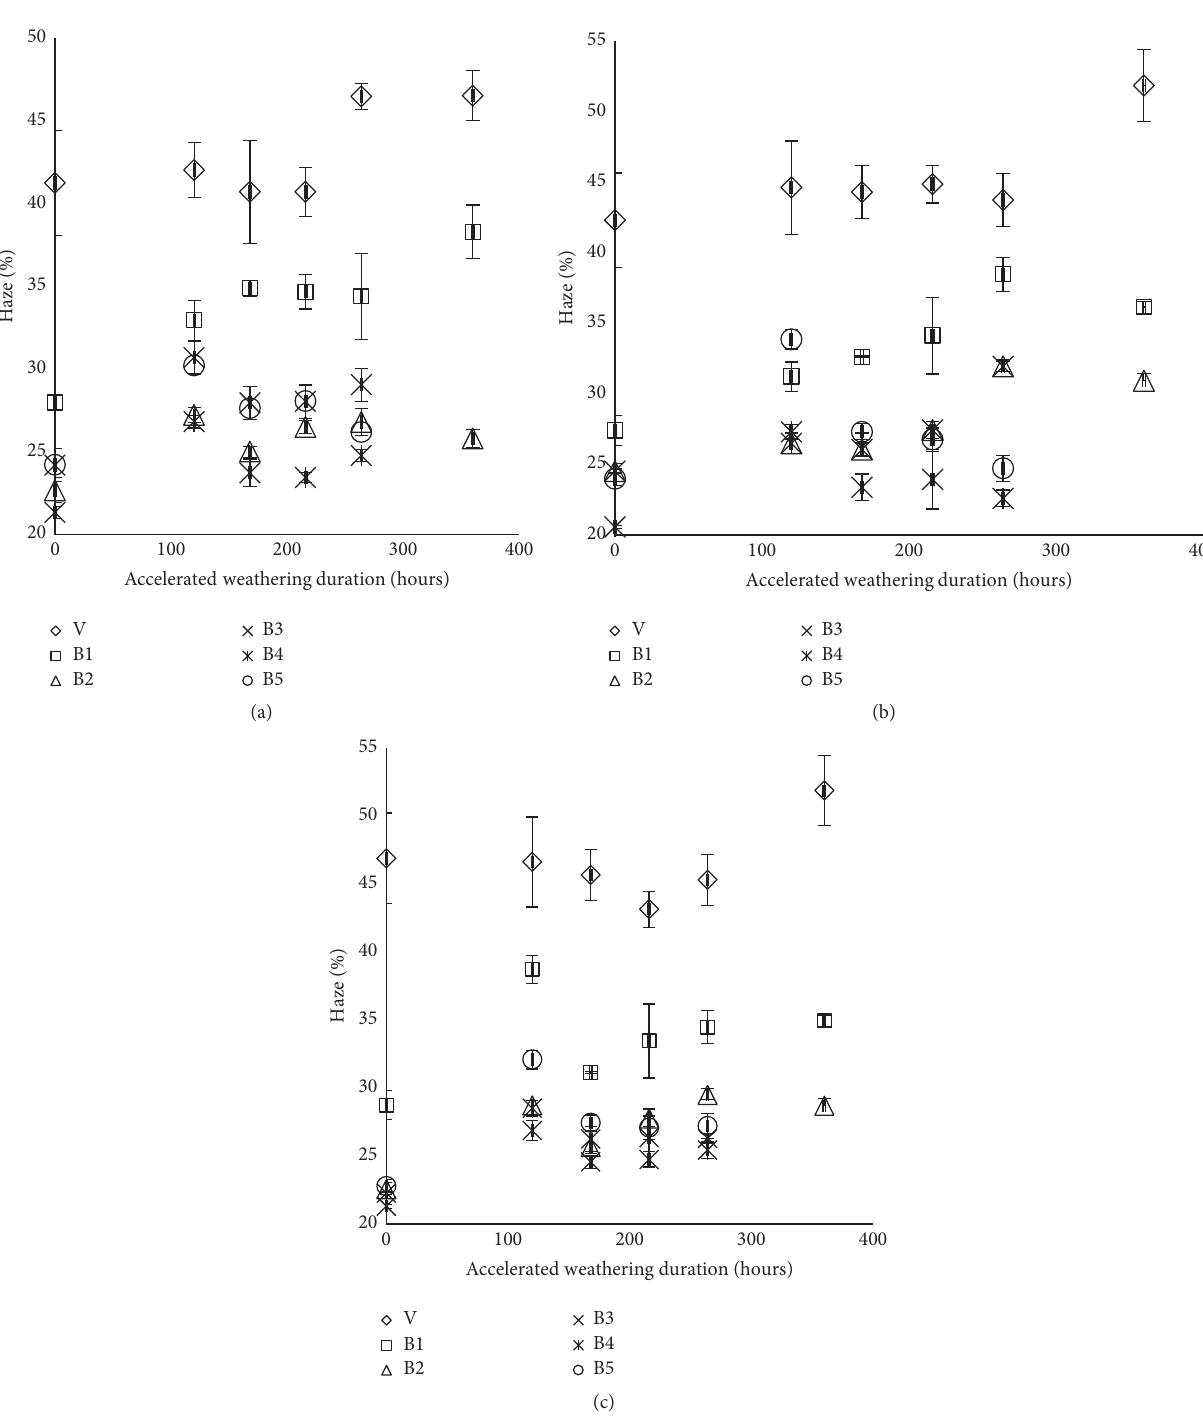
Figure 8: Haze (%) of the formulated samples with respect to accelerated weathering duration (days). Samples processed with a Die Head Temperature (DHT) = 175, 185, and 195 ∘ C are shown in (a), (b), and (c),